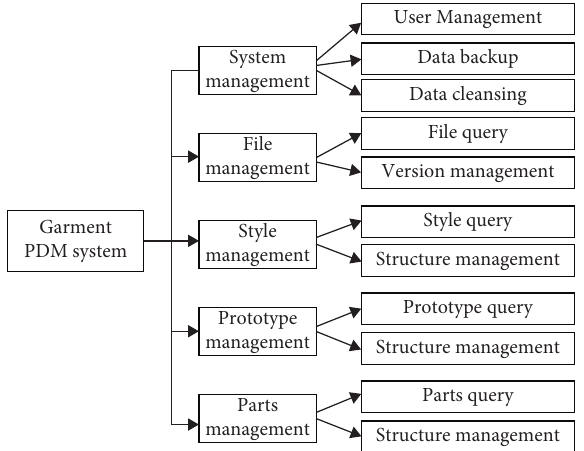
Figure 8: Function module of CAD intelligent analysis of garment